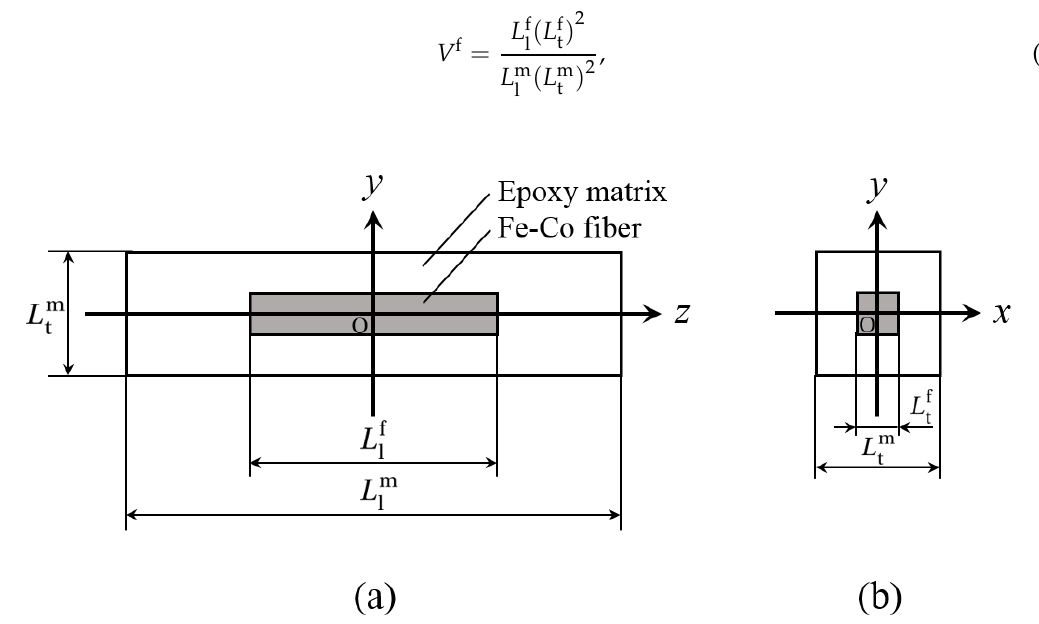
Figure 3. Representative volume element (RVE) model of the discontinuous Fe-Co fiber / epoxy composite: ( a ) x = 0 plane and ( b ) z = 0 plane.